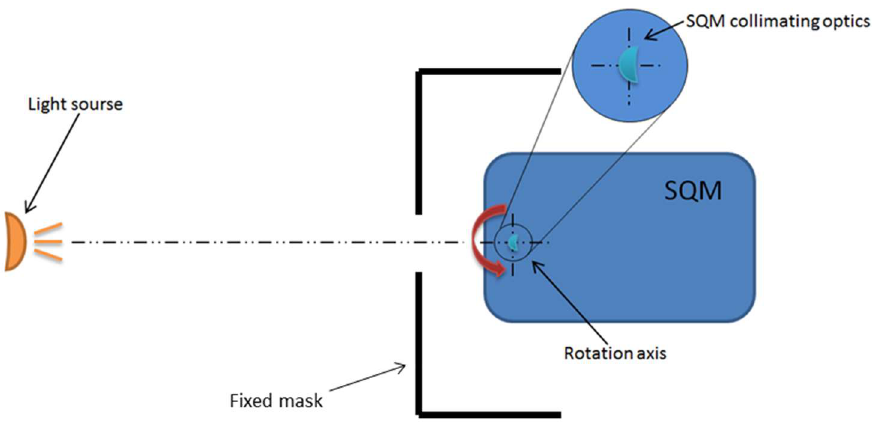
Figure 2. Sketch of test setup, highlighting the position of the rotation axis, centered on the SQM collimating optics.